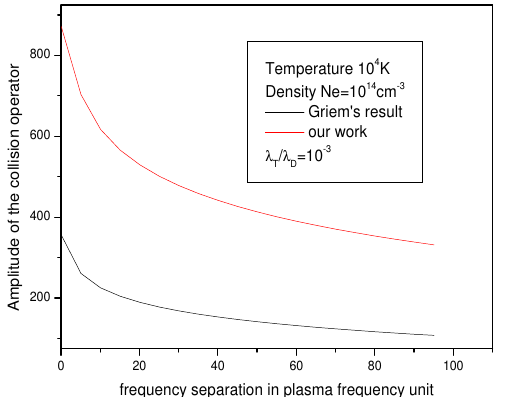
Figure 1. Amplitude of collision operator versus frequency separation in plasma frequency unit ¯ ω αα (cid:48) for Ne = 10 14 cm − 3 and 10,000 K. The amplitude is in π 2 A /768 unit, where A is defined in the text as Equation